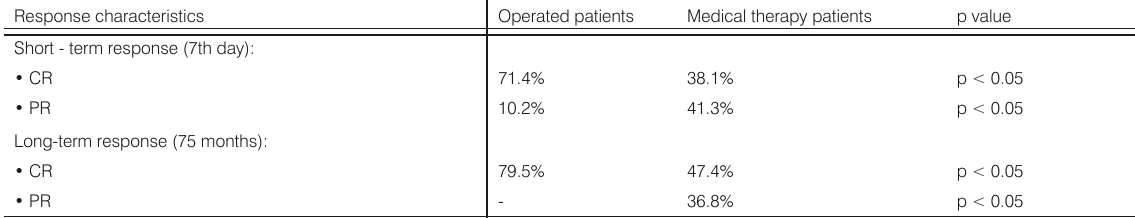
Table 2. Treatment